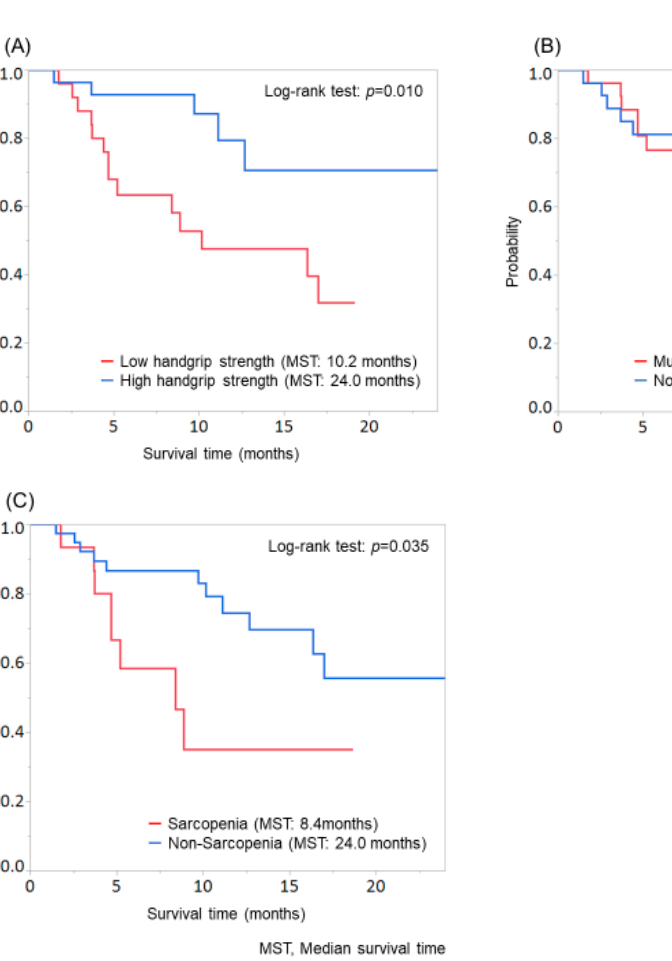
Figure 2. Comparison of overall survival according to the evaluation of handgrip strength, skeletal muscle, or sarcopenia. ( A ) Patients with low handgrip strength showed significantly shorter survival than those with high handgrip strength (MST: low handgrip strength group, 10.2 months; high handgrip strength group, 24.0 months; p = 0.010). ( B ) No significant di ff erence was found between patients with and without muscle depletion ( p = 0.675). ( C ) Patients with sarcopenia showed significantly shorter survival than those without sarcopenia (MST: sarcopenia group, 8.4 months; non-sarcopenia group, 24.0 months; p = 0.035).